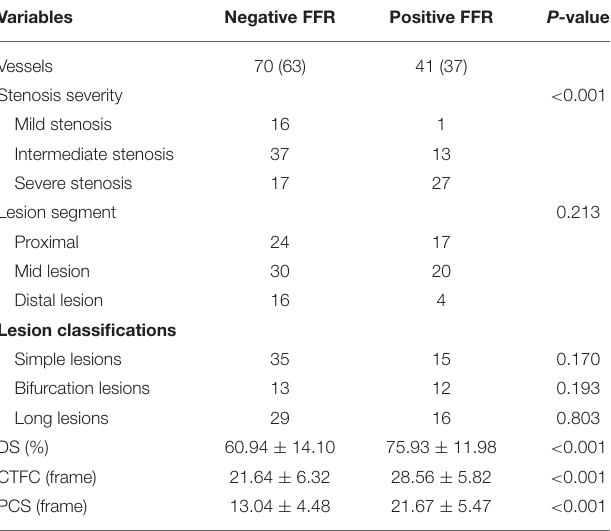
TABLE 2 | Angiographic characteristics in vessels according to invasive FFR.